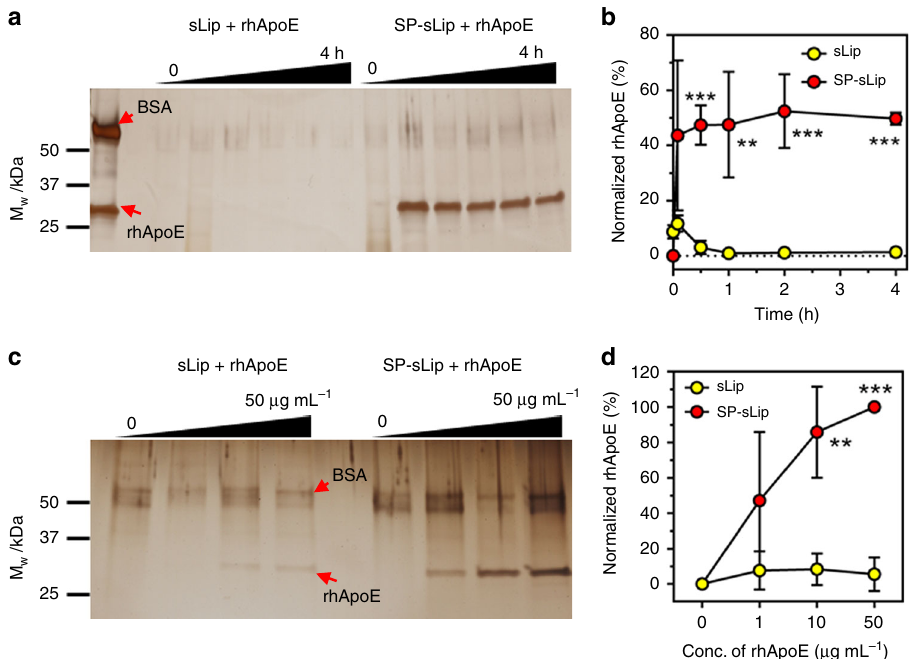
Fig. 1 Binding kinetics and capacity of recombinant human ApoE (rhApoE) on liposomal surface. a , b rhApoE and the same amount of BSA mixture in 100 μ L PBS was incubated with 100 μ L sLip or SP-sLip for 0, 5, 30, 60, 120, and 240 min at 37 °C (rhApoE, 10 μ g mL − 1 ; phospholipid, 5 mg mL − 1 ). Protein coronas were obtained by centrifugation at 14k RCF for 20 min, loaded to 4 – 20% SDS-PAGE gel for separation and stained with silver. The band intensity of absorbed BSA and rhAPOE was calculated by image J software and normalized by setting BSA intensity in the control panel as 100. c , d rhApoE ( fi nal concentration of 0, 1, 10, and 50 μ g mL − 1 ) and the same amount of BSA mixture in 100 μ L PBS was incubated with 100 μ L sLip or SP-sLip for 1 h at 37 °C. Protein coronas were obtained as in a . The band intensity of absorbed rhApoE was calculated and normalized by setting that in the 50 μ g mL − 1 rhApoE panel as 100. Data are means± SD ( n = 3), and analyzed with GraphPad Prism 6.0. ** p < 0.01, *** p < 0.001 by student ’ s t-